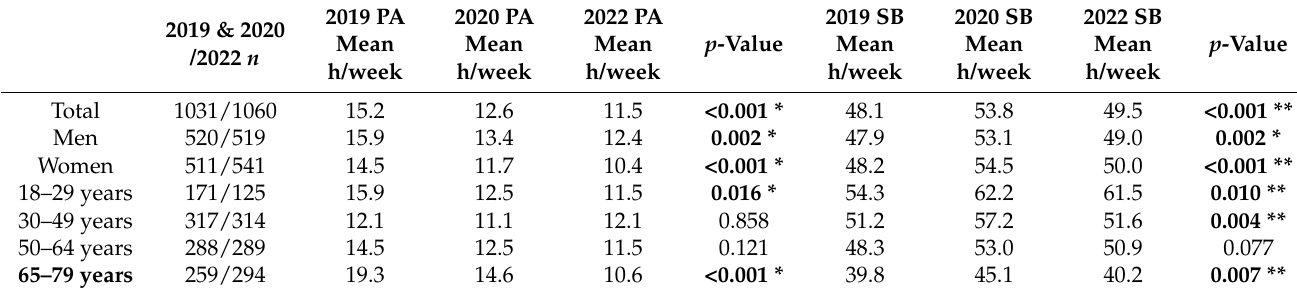
Table 2. Physical activity (PA) and sedentary behavior (SB) over time.